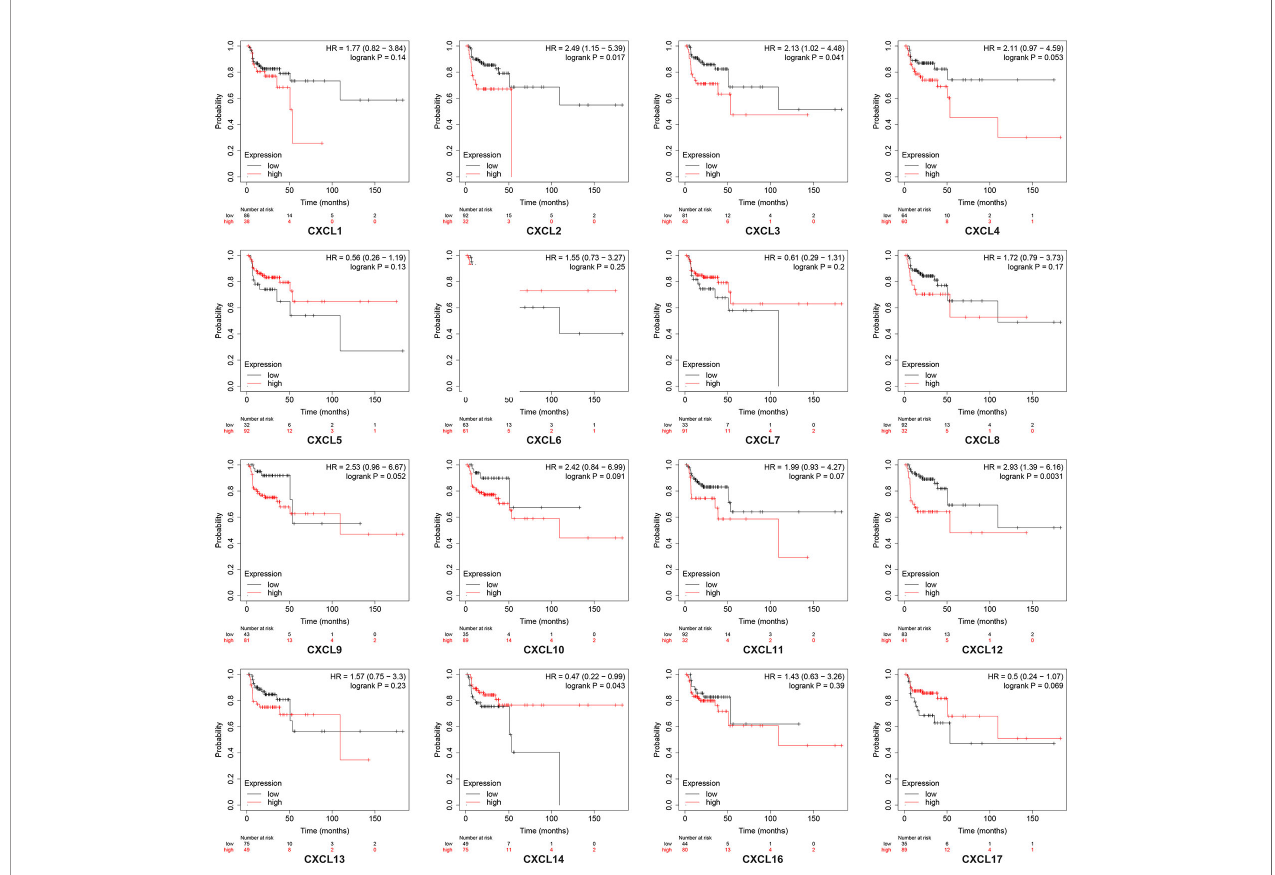
FIGURE 8 | Kaplan-Meier curve reveals the relapse-free survival differences based on mRNA level of CXC chemokines in HNSCC